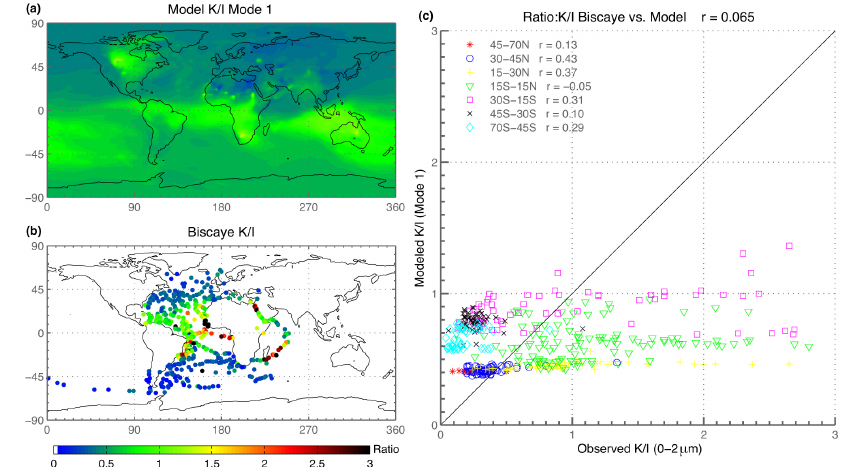
Figure 8. Kaolinite/illite mineral ratio of wet and dry deposition for mode 1 from CAM5 (a) (kgK / kgI) and from characteristic basal X-ray diffraction maxima ratios of K / I of ocean core sediments (b) (Biscaye 1965). Data are segregated by latitude bands in scatterplot (c) . Table 7. Comparison of observed top-of-atmosphere clear-sky radiative forcing efficiencies (RFEs) (Wm − 2 τ − 1 ) over the North Atlantic and north Africa regions with simulated RFE. Simulations are for CAM4 and CAM5 with release dust, tuned dust and mineralogy in the upper portion of the table. The sensitivity studies with tuned dust and release size distribution, and with the source of hematite coming solely from the soil clay fraction for CAM4 and CAM5, comprise the lower portion of the